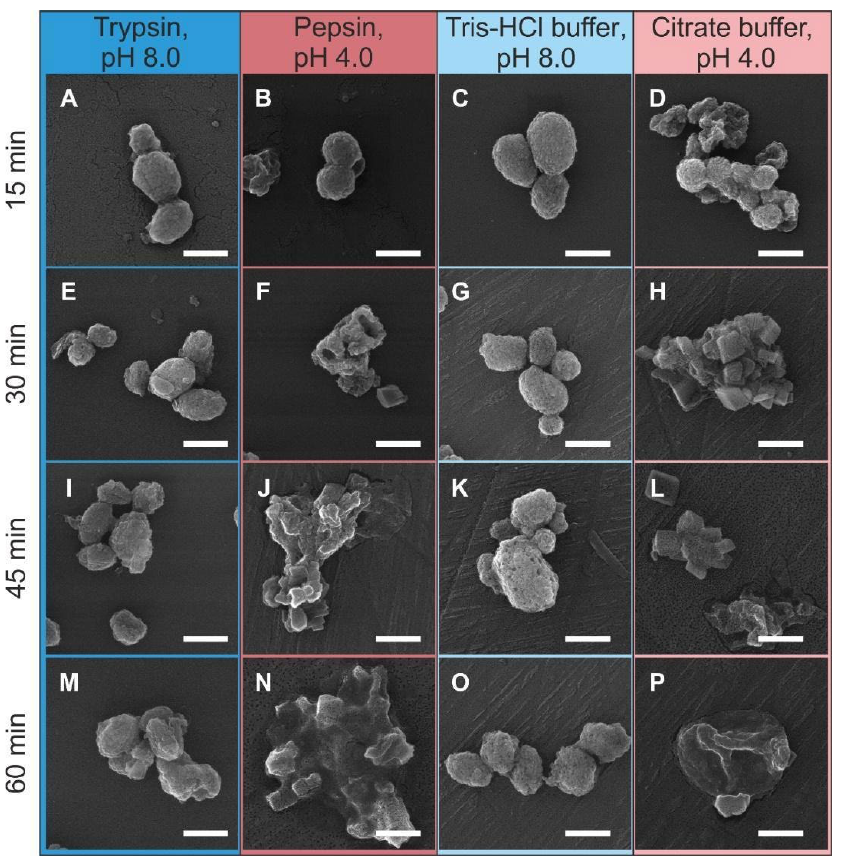
Figure 6. SEM-images of CaCO 3 /MNP 3 /(BSA-Cy7/TA) 2 structures after incubation in solution of trypsin (1 mg/mL) in 50 mM Tris-HCl buffer (pH 8.0) ( A , E , I , M ), pepsin (1 mg/mL) in 50 mM citrate buffer (pH 4.0) ( B , F , J , N ), and in pure buffer solutions: 50 mM Tris-HCl buffer (pH 8.0) ( C , G , K , O ) and 50 mM citrate buffer (pH 4.0) ( D , H , L , P ). The scale bar corresponds to 1 µm.